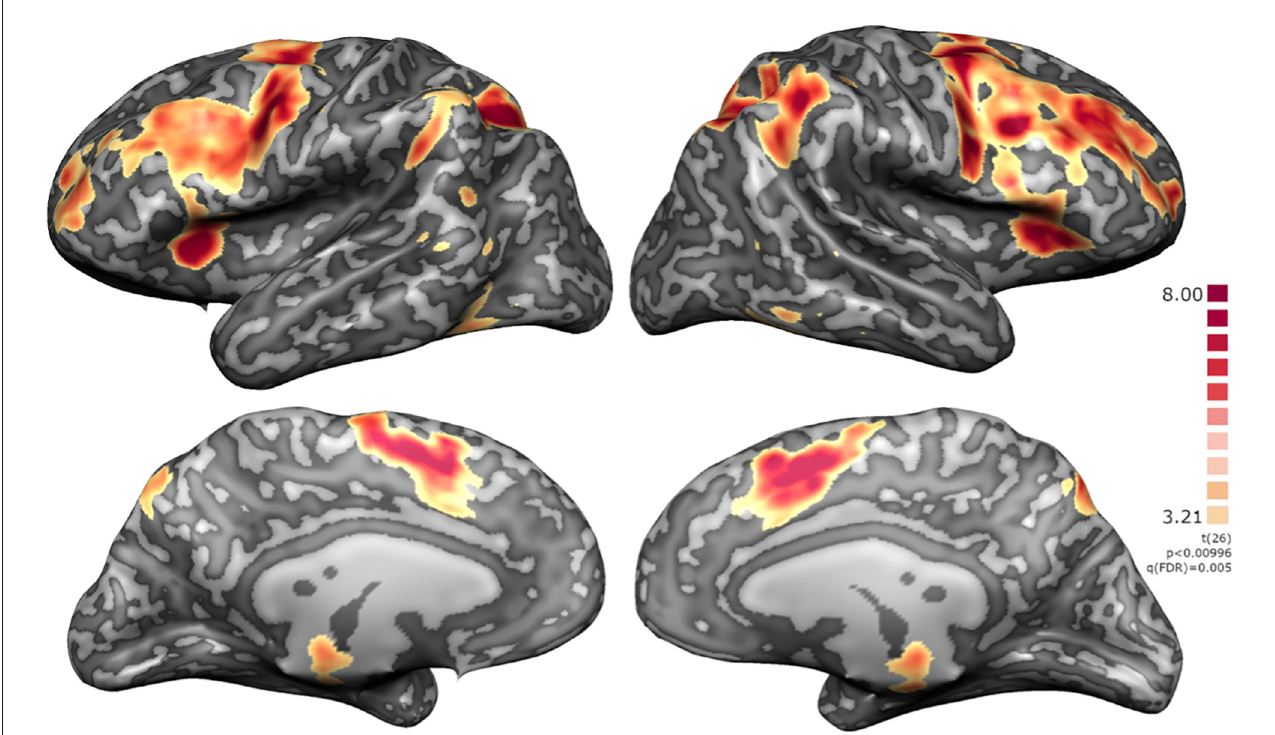
FIGURE5 Localizer RFX map for N = 27. Activation clusters include regions integrated in executive functions network, namely DLPFC, premotor cortex, supplementary motor area (SMA), basal ganglia, thalamus, intraparietal sulcus (IPS), anterior insula, superior frontal gyrus (SFG), superior vermis (cerebellum), and red nucleus/substantia nigra (RN/SN).